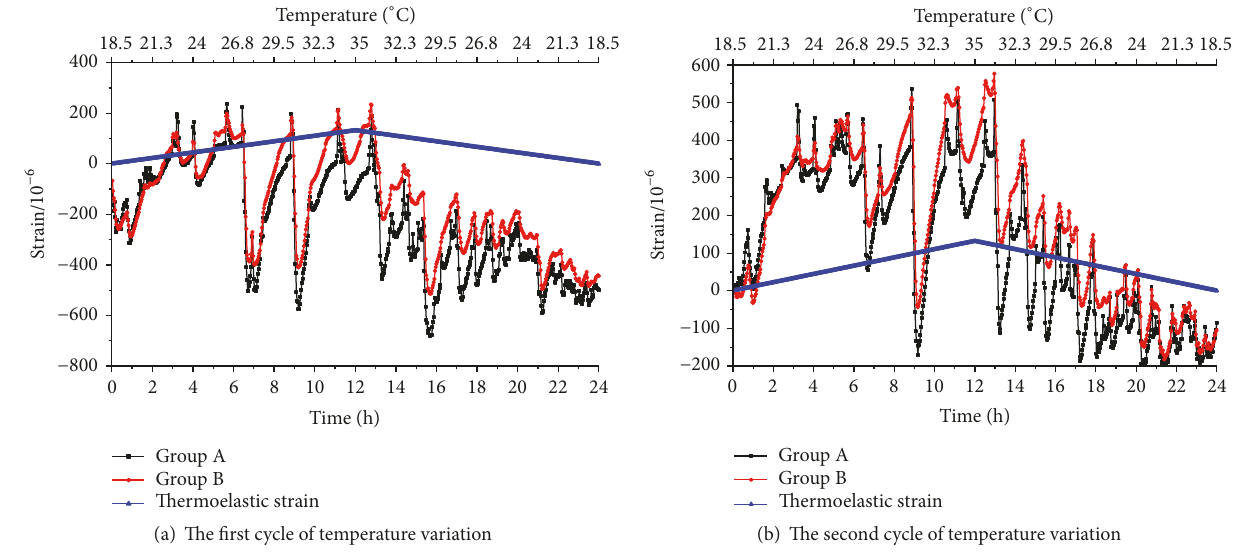
Figure 4: Strain of